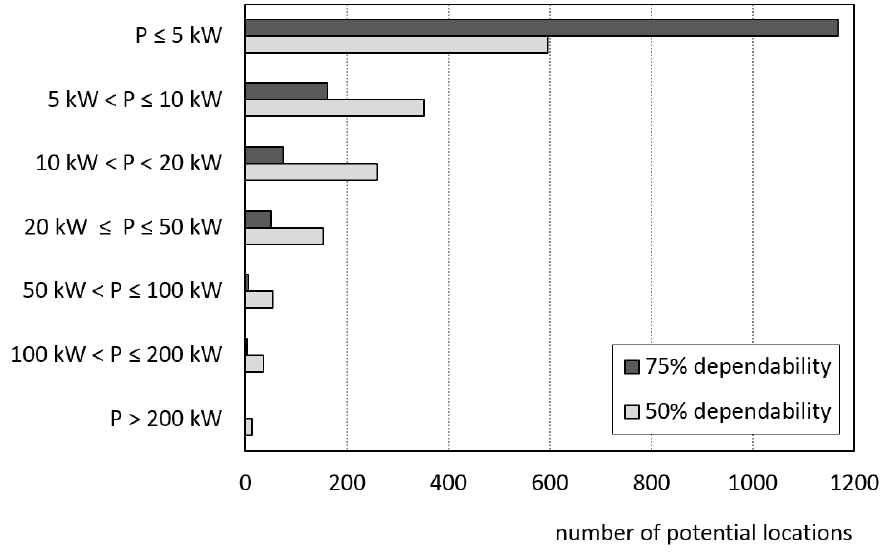
Figure 10. Number of potential power locations for different ranges of power (50% and 75% dependability).